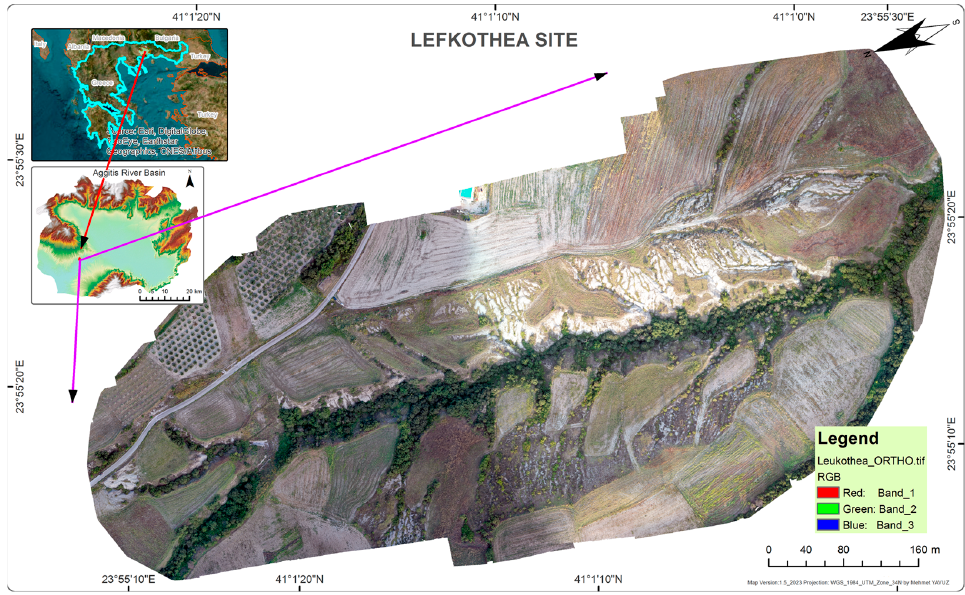
Figure 2. The location of the Lefkothea study site within the Aggitis River Watershed in Greece.